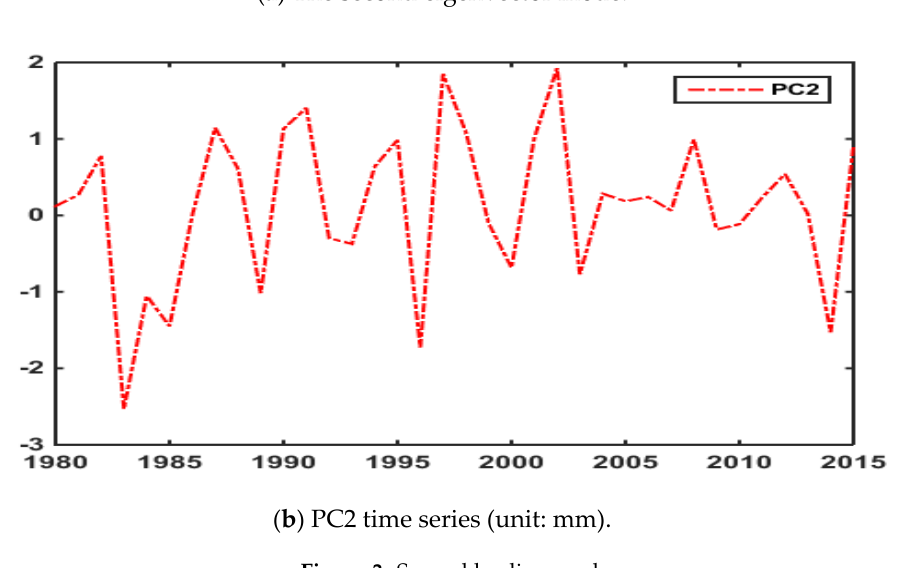
Figure 3. Second leading mode.